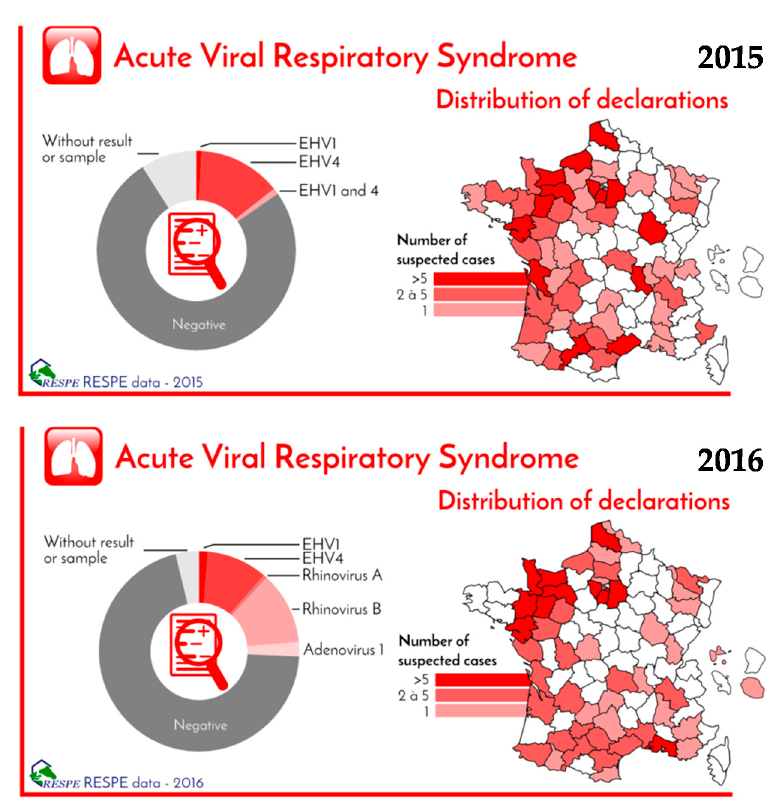
Figure 4. Equine acute viral respiratory disease reported to the French Epidemiological Surveillance of Equine Pathologies (RESPE) in 2015 and 2016. Causative agents and geographical localization are presented.